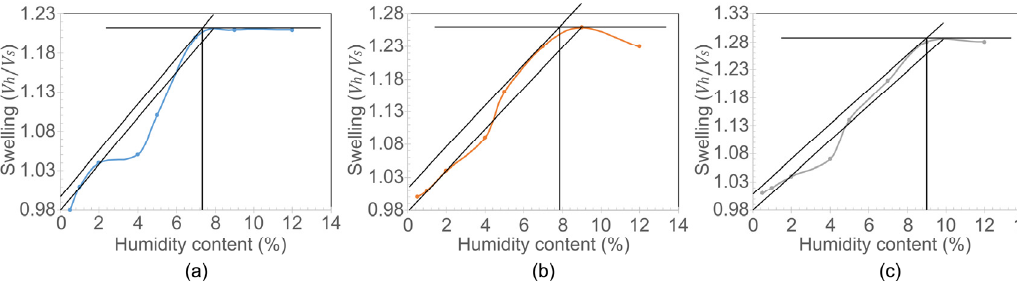
Figure 3. Swelling coefficient as a function of moisture content for CDW classified as ( a ) coarse; ( b ) medium; and ( c ) fine.